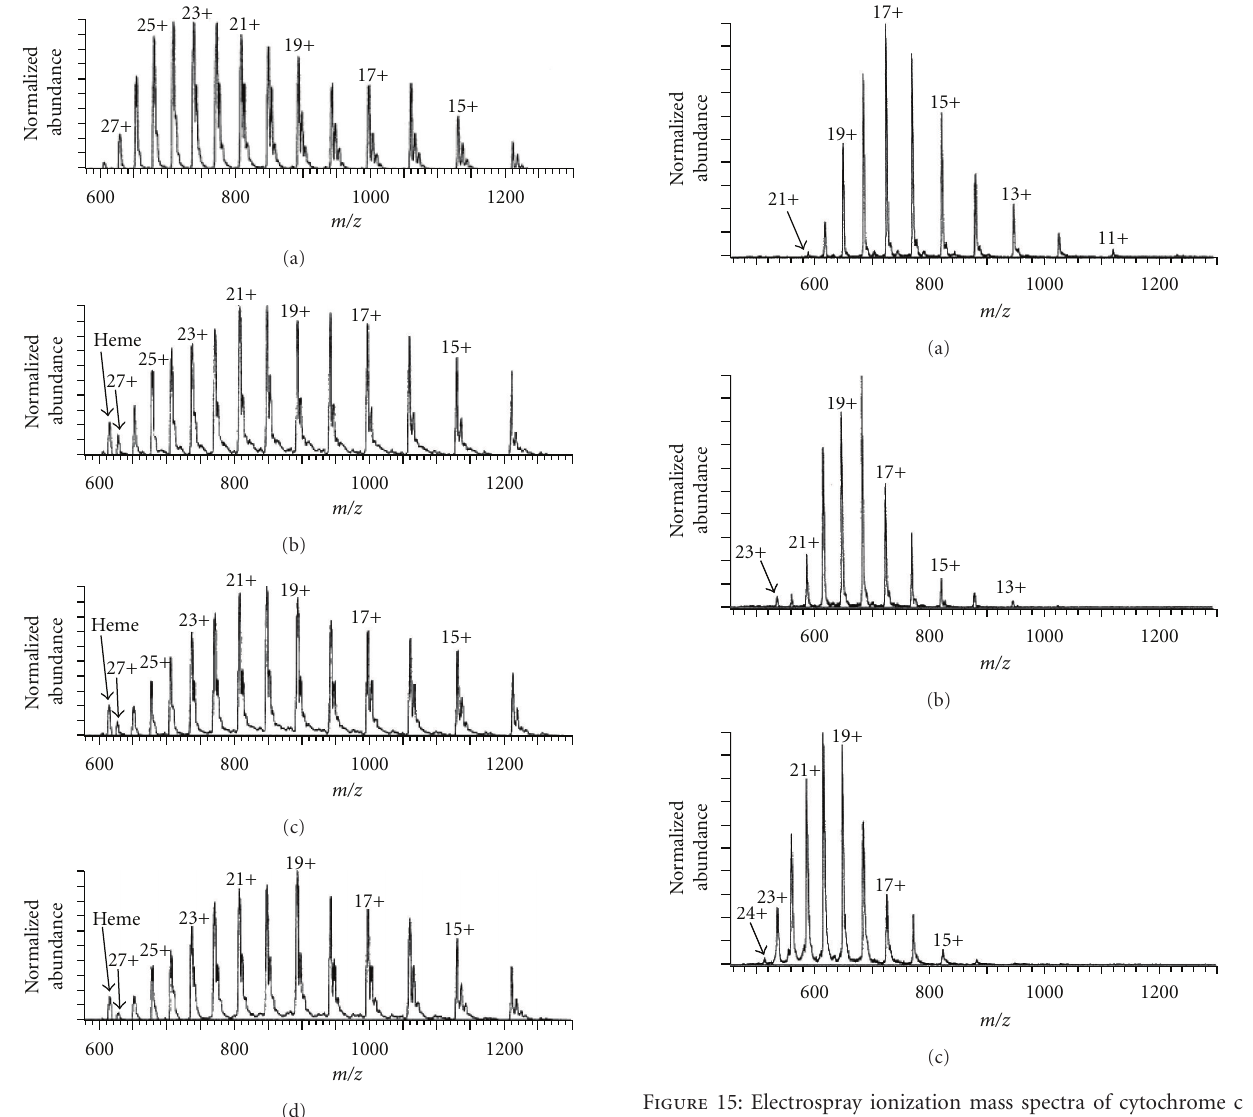
Figure 15: Electrospray ionization mass spectra of cytochrome c (10 − 5 M) from solutions containing (a) 0, (b) 0.3, and (c) 0.7% m- NBA. The base solution is 47/50/3% water/methanol/acetic acid. (Reprinted with permission from Analytical Chemistry [101], Copy- right 2001, American Chemical